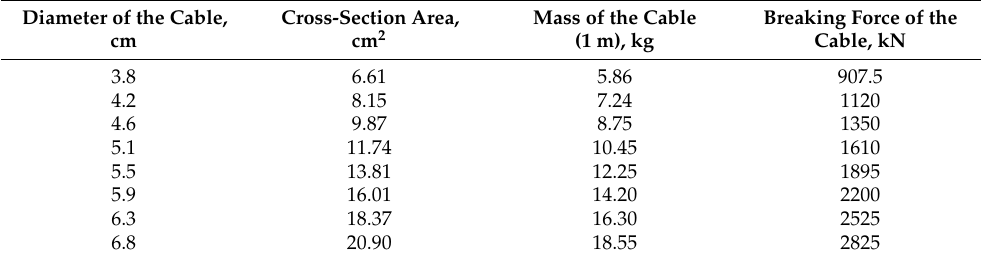
Figure 6. The view of the cross-section of the equal-leg angles, back-to-back type: ( a ) equal-leg angle; ( b ) composed section. Table 2. Steel cable’s geometric, physical and mechanical dimensions by GOST 3068-66 (shortened) for the tie member (cable) of the